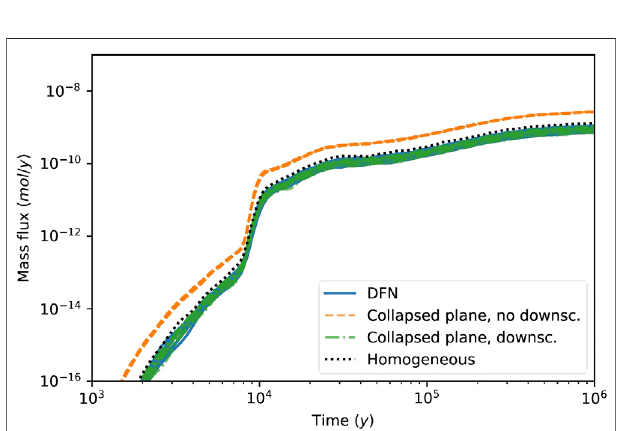
FIGURE 8 | Decay Chain case : breakthrough curves of Ra226 computed using transport pathways obtained using the different realisations oftheDFNmodel(bluecontinuouscurves)comparedwithrelatedcalculations carried out using transport pathways derived from the collapsed plane model and without downscaling (orange dashed lines), with related calculations carried out using transport pathways derived from the collapsed planemodelandwithdownscalingappliedusingthestandardalgorithm(SDA) (green dashed-dotted lines) and with calculations carried out using the single straight transport pathways derived from the homogeneous plane model and with downscaling applied using the projected sub-segment algorithm (PSSA) (orange dotted line).